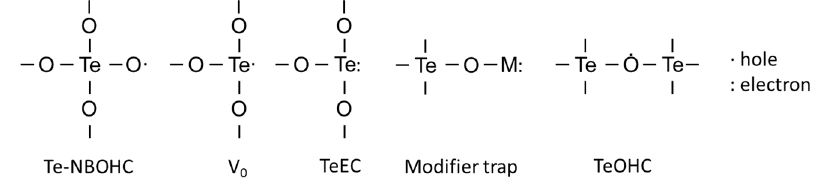
Figure 4. Defects in tellurite glasses.